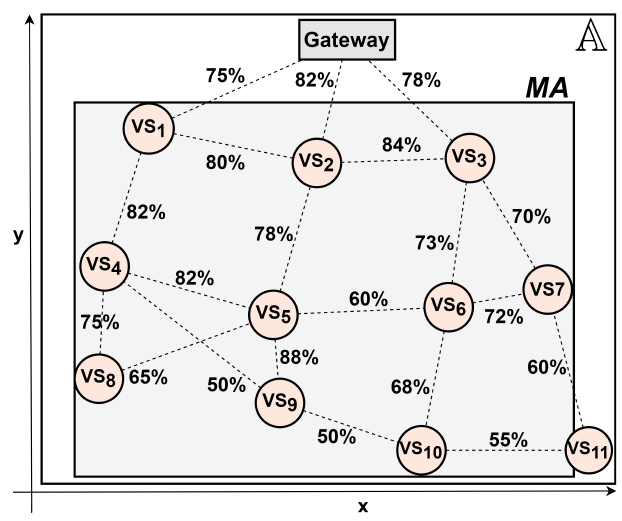
Figure 10. Shop floor